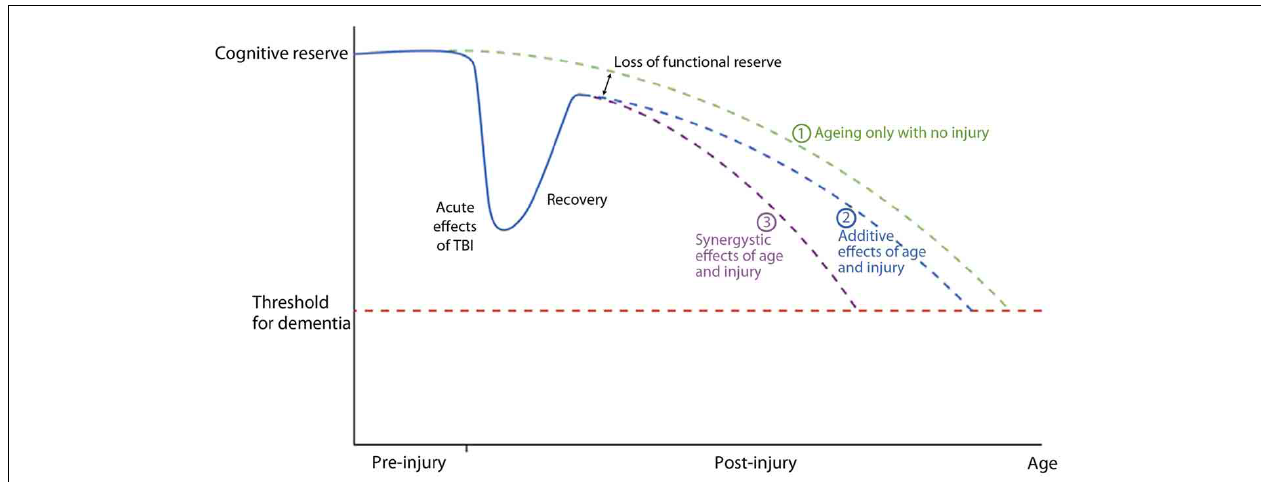
the head injury. Recovery is, however, not complete resulting in a loss of functional reserve. After this point cognitive decline may be as for normal ageing [broken blue line (2)] with the dementia threshold being crossed earlier due to loss of functional reserve, or there may be a continued synergistic effect of mechanisms initiated by the head injury which accelerates cognitive decline [broken purple line (3)]. Reproduced with permission from John Wiley and Sons and Smith